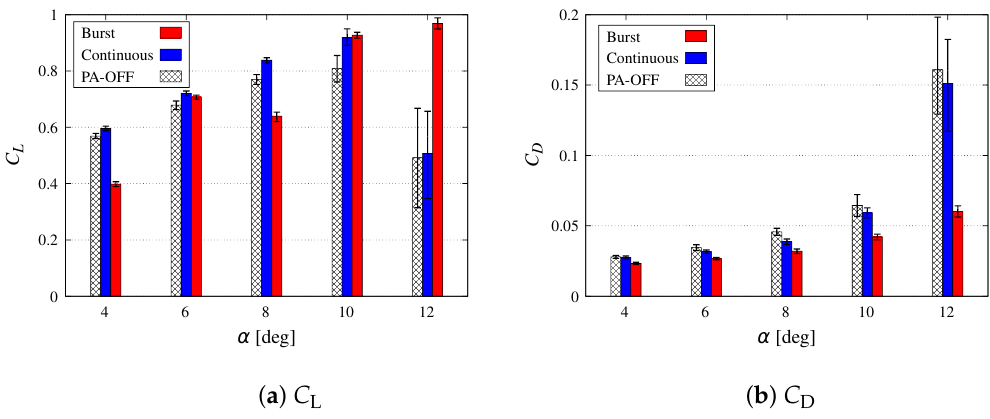
Figure 7. Lift coefficient ( C L ) and drag coefficient ( C D ) versus angle of attack ( α ).